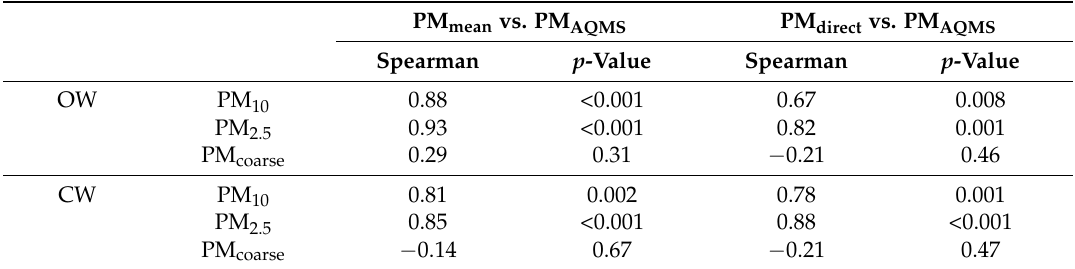
Table 4. Correlation coefficients for in-cabin PM concentrations and PM concentrations from the